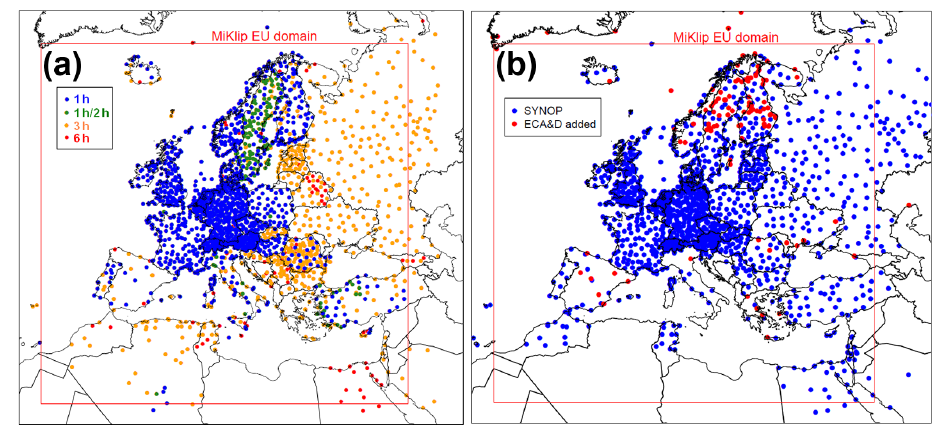
Figure 1. (a) SYNOP stations with hourly data in target DecReg EU domain for January 2010. The color code indicates the frequency of reports (between 1 and 6h). The station records marked green contain hourly data but show gaps for the main dates: 00:00, 03:00, 06:00UTC, etc. (b) SYNOP data for T avg (blue) in January 2001 and added ECA&D data using selection algorithm described in the text.